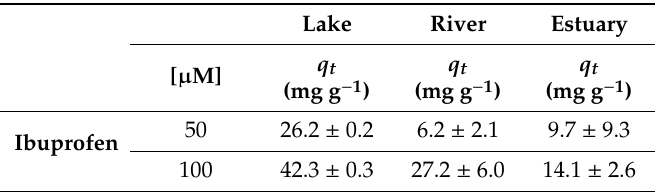
Table 2. Adsorption capacity, q t (mg g − 1 ), of ibuprofen by TpBD-(CF 3 ) 2 at 21 ◦ C; t = 2 h; covalent organic framework (COF) concentration of 330 mg L − 1